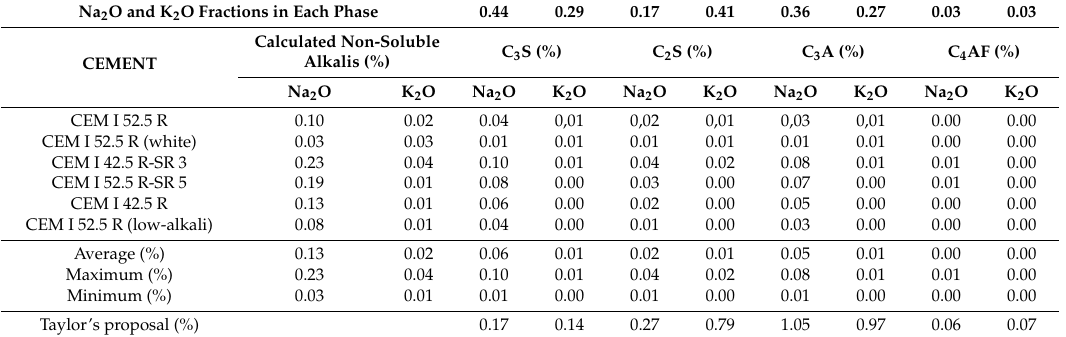
Taylor’s proposal